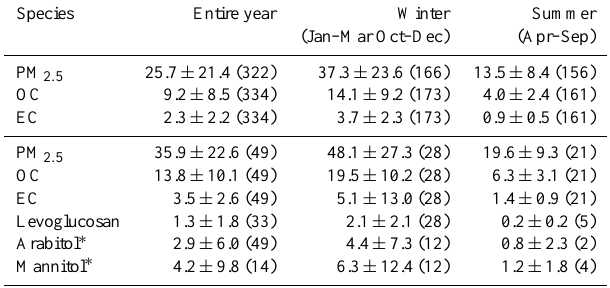
Table 3. Annual and seasonal average concentrations of PM 2 . 5 , OC, EC, corresponding to the entire set of samples collected dur- ing 2007 (upper part) together with PM 2 . 5 , OC, EC, levoglucosan, arabitol, and mannitol averages corresponding to the subset of 48 samples (lower part). Concentrations are in µgm − 3 and standard deviations are reported. Average values are calculated assigning one half of detection limit concentration to samples below detection limit (Antweiler and Taylor, 2008), and the number of samples with concentration above detection limit is reported between brackets.